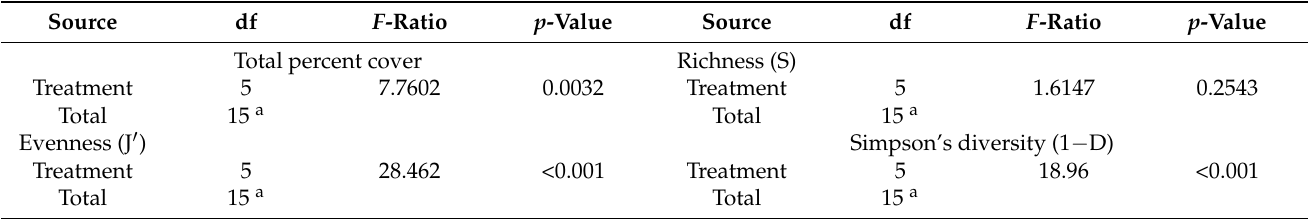
Table 5. Summary of one-way ANOVA of the effect of amendment application (PMS50, PMS50+N5, topsoil, topsoil+N5, N3, N5) on total percent cover, richness (S), Pielou’s evenness (J (cid:48) ), and Simpson’s index (1 − D) at the Mont-Wright site.